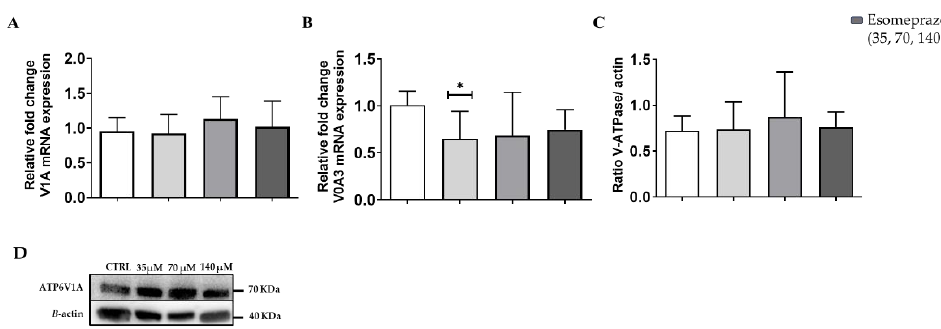
Figure 3. V-ATPase mRNA expression for the subunits V1A ( A ) and V0A3 ( B ); quantification of protein level ( C ) and Western Blot analysis ( D ) of PC3 cells after 24 h Esomeprazole treatment. White columns represent the control; grey-colored columns represent the three different concentrations of esomeprazole. ANOVA statistical analysis with Bonferroni post-hoc correction was applied (* p value < 0.05).